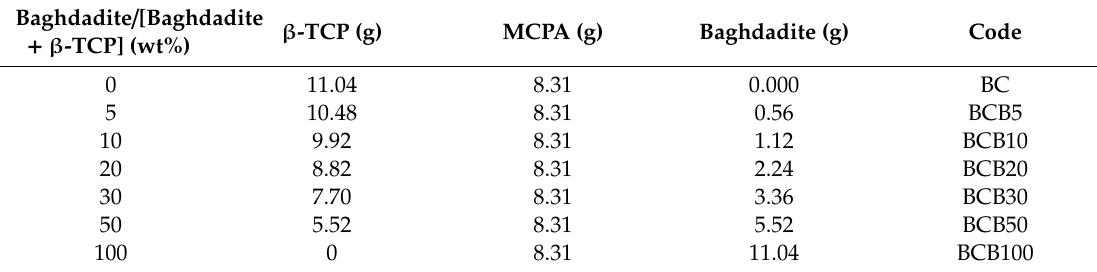
Table 1. Composition of the powder reactants per gram for each cement formulation investigated in this